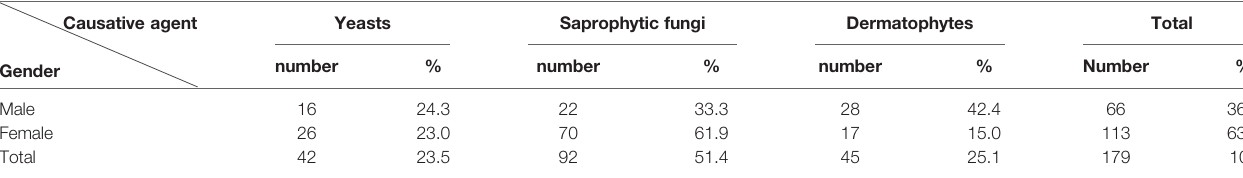
TABLE 2 | The frequency of causative agents of onychomycosis in regard to patient ’ s gender. Causative